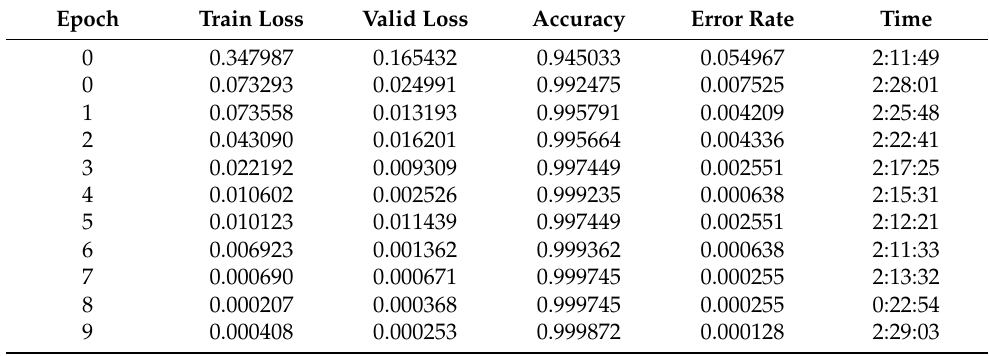
Table 10. Results of DenseNet